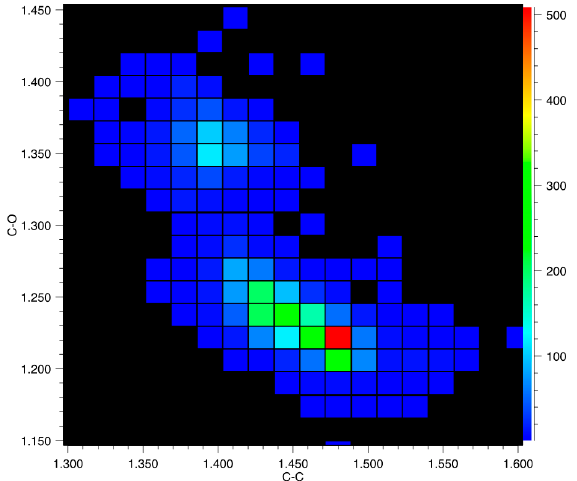
Figure 5. Analysis of the 2-pyridone / 2-hydroxy-pyridine tautomerism in purely organic compounds in the Cambridge Structure Database (CSD). Using the atom numbering in Figure 1, we have plotted the distances of C1-O1 versus C1-C2 and the colors represent number of hits in the database.